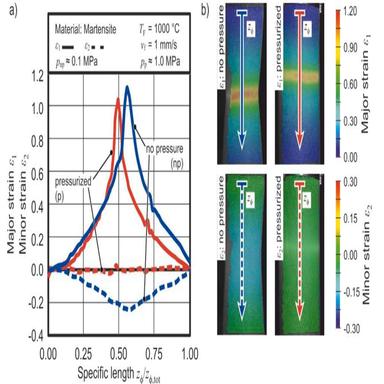
a) Principal strain distribution of the pressurized-tube-tensile test with (p) / without (np) internal pressure in the last image before failure over the meridian path zϕ and b) used DIC images as well as the corresponding paths for the evaluation.